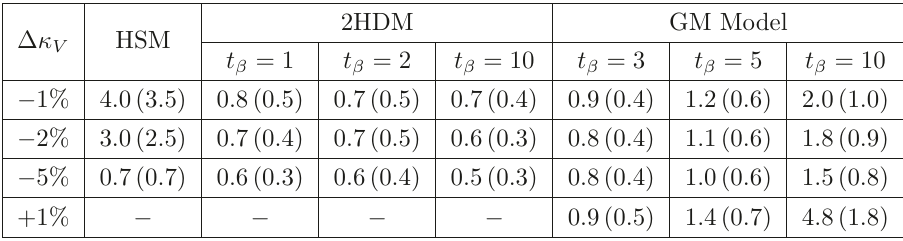
Table 3 . Summary of the upper bounds on M 2nd (TeV) by Bound A (by Bound B requiring the cutoff scale to be above 10 TeV) in the models considered for reference values of ∆ κ V